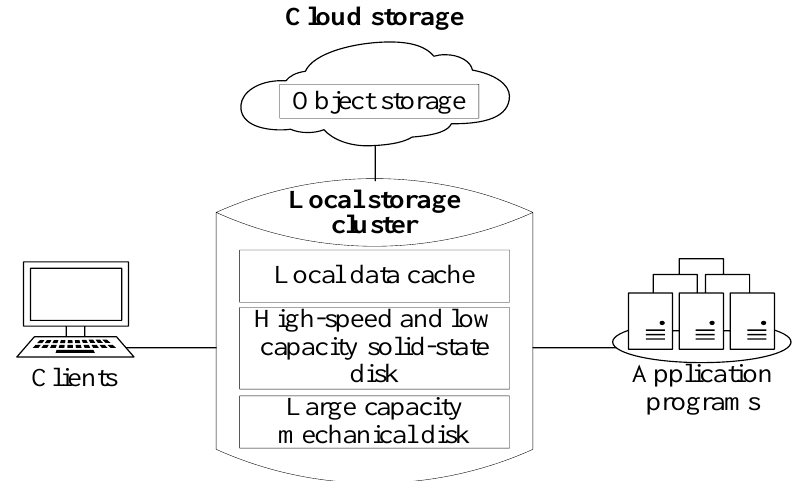
Figure 1. Multi-tier storage architecture of remote sensing image